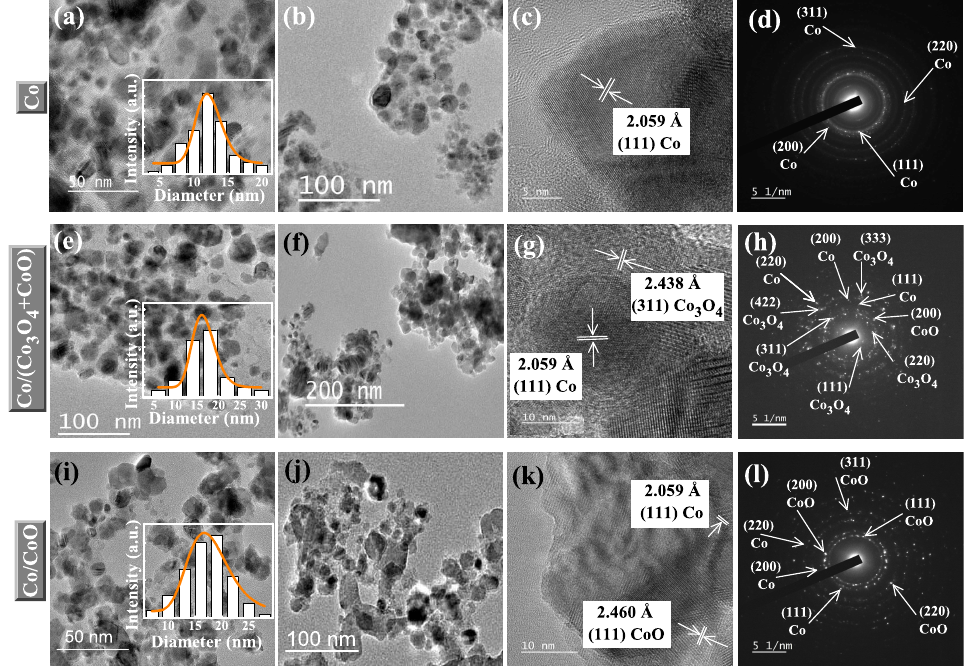
Figure 3. TEM images of Co ( a , b ), Co/(Co 3 O 4 + CoO) ( e , f )) and Co/CoO ( i , j ) show well dispersed particles with distribution of particle sizes. Insets of ( a , e , i ) depict the histograms of particle sizes, fitted with log-normal distribution function. ( c , g , k ) HR TEM images, highlighting plane spacings of Co, Co 3 O 4 and CoO. ( d , h , l ) correspond to SAED pattern of the three samples, indicating different crystalline planes which are in accordance with the PXRD